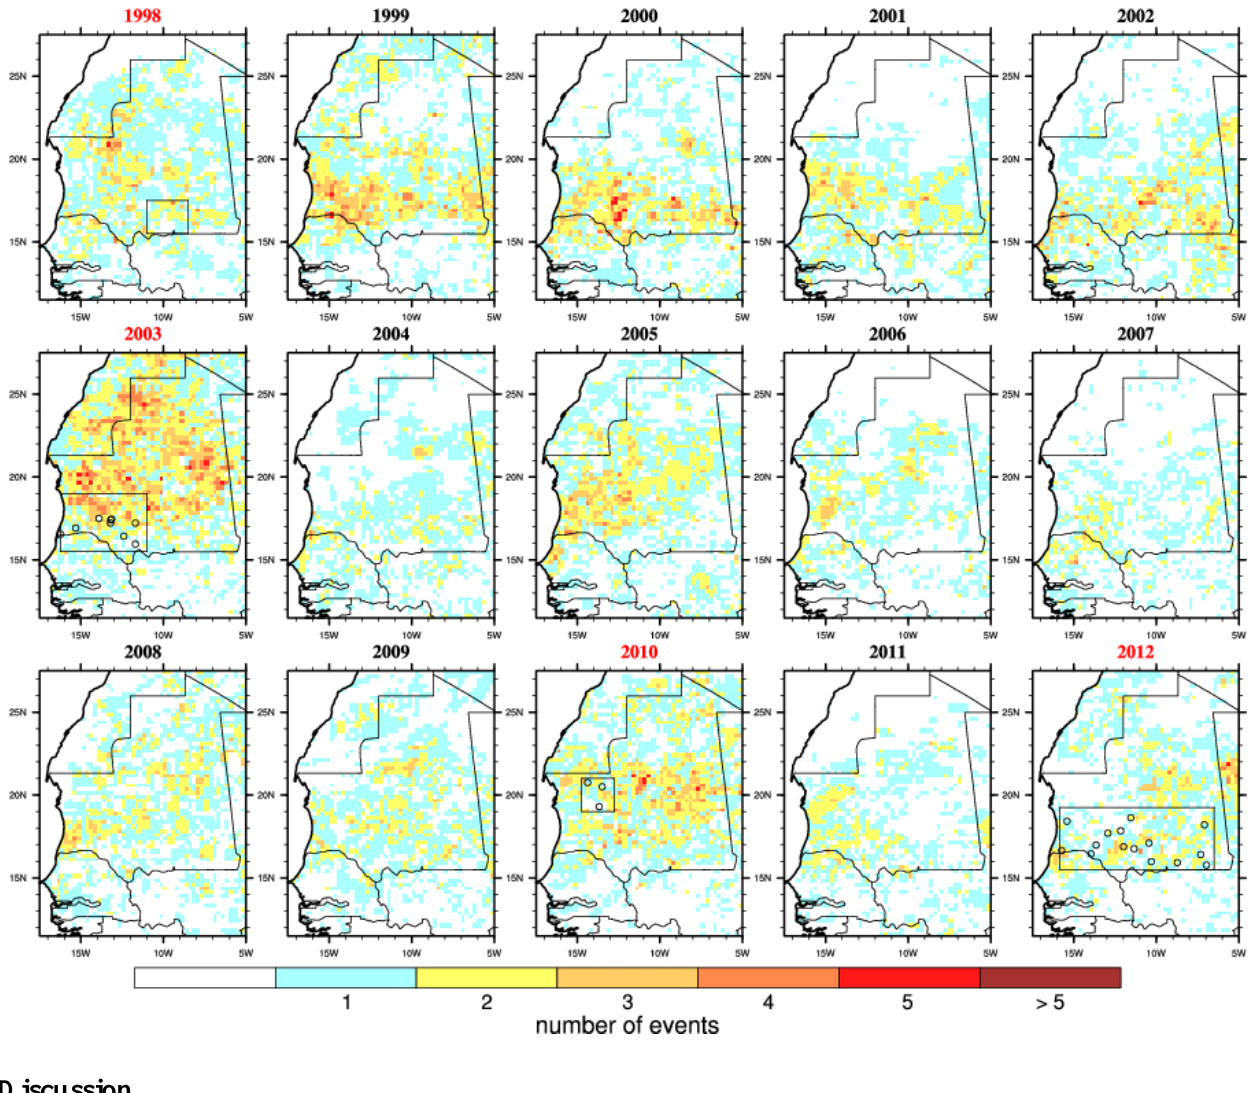
Figure 5. Number of embryogenesis risk events. This is defined by a dry spell (7 consecutive days with no rainfall) followed by a convective event (≥10 mm) occurring during the late rainy season (August–September–October). Outbreak years are highlighted in red and the locations of reported infections are shown by